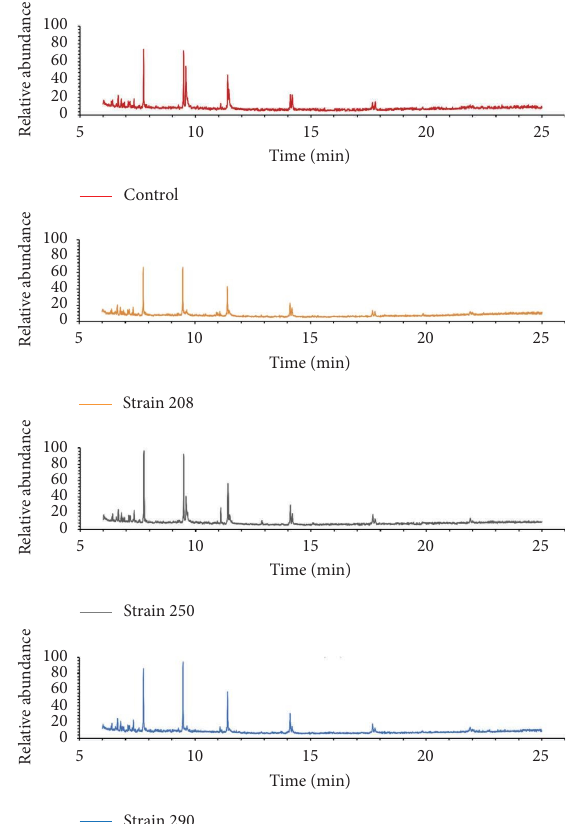
Figure 4: GC-MS chromatogram for the organic extracts of culture media supernatant for each strain. Te control is supernatant with no bacterial exposure.